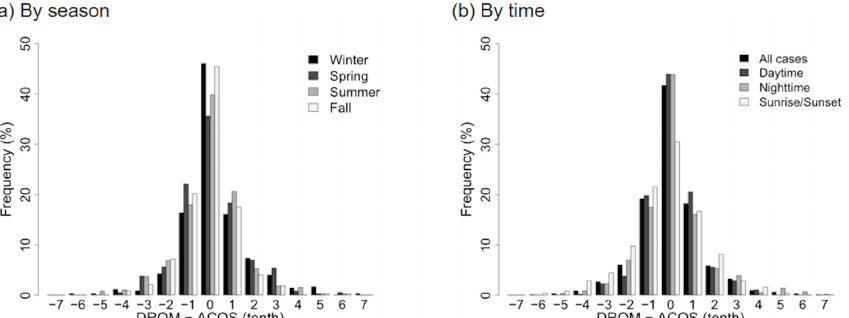
Figure 8. Relative frequency distributions of differences between observed (DROM) and calculated (ACOS) cloud cover by season and time for the test